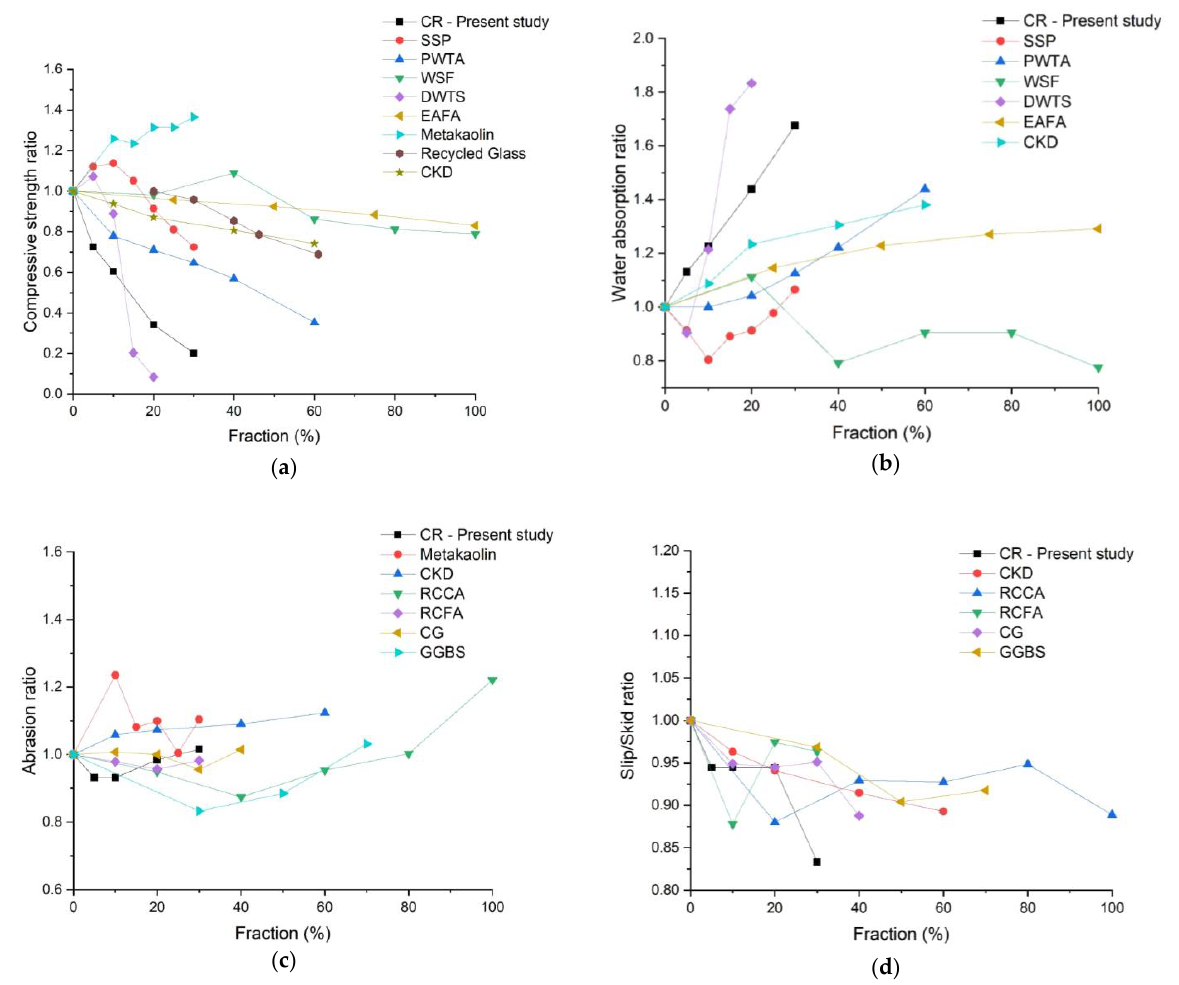
Figure 16. Effects of various materials on the properties of IPB, ( a ) compressive strength; ( b ) water absorption; ( c ) Abrasion, and; ( d ) Skid resistance.